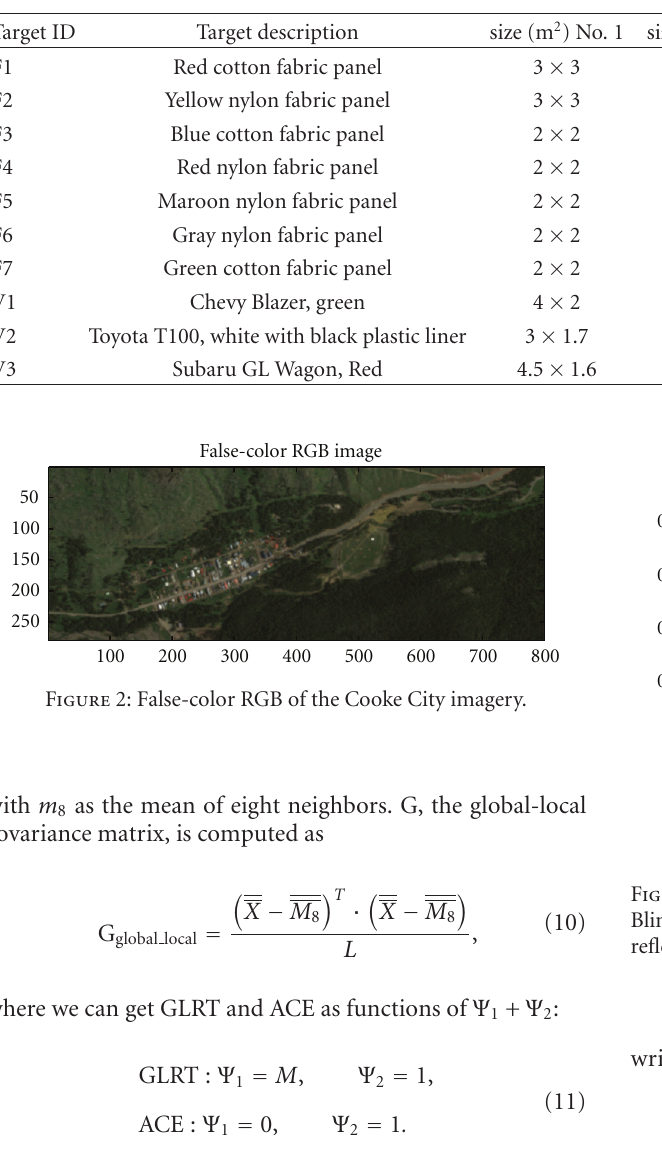
Table 1: Targets description.